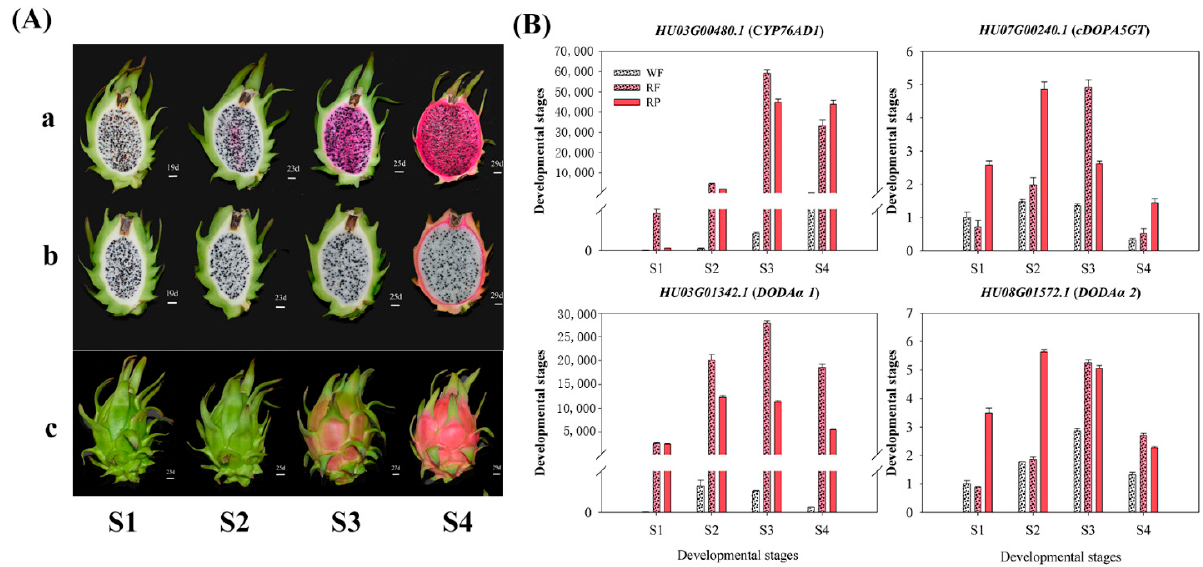
Figure 1. Identification of H. undatus CYP76AD , DODA and GTs as candidate betalain biosynthesis-related genes. ( A ) Pitaya peels and pulps from four developmental stages used for gene expression. ( a ) pulps of ‘Guanhuahong’ pitaya. ( b ) pulps of ‘Guanhuabai’ pitaya. ( c ) peels of ‘Guanhuahong’ pitaya. ( B ) Expression patterns of betalain biosynthesis-related genes of HmoCYP76AD1 , HmoDODA α 1 , HmoDODA α 2 and HmocDOPA5GT . WF, pulps of ‘Guanhuabai’ pitaya; RF, pulps of ‘Guanhuahong’ pitaya; RP, peels of ‘Guanhuahong’ pitaya.